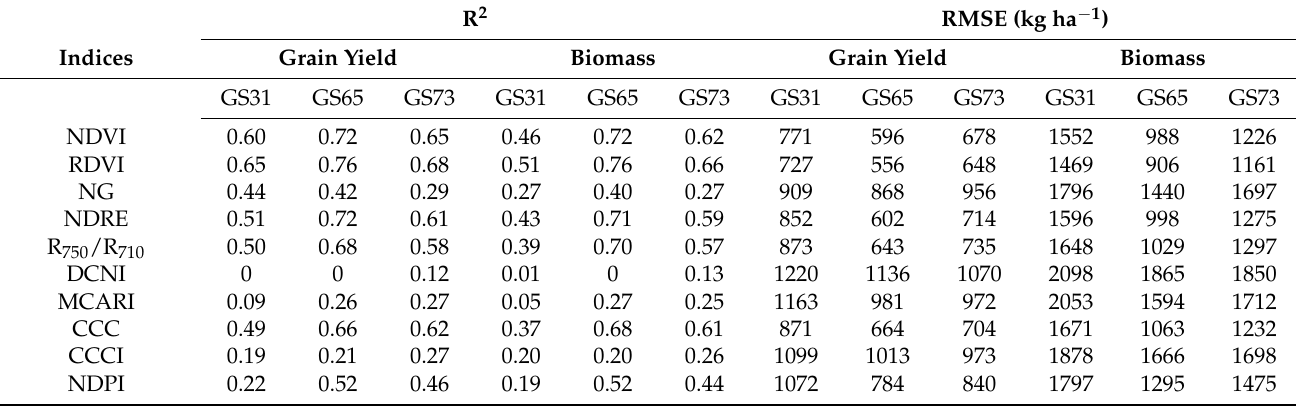
Table 2. Coefficient of determination (R 2 ) and root mean square error (RMSE) between vegetation indices and grain yield and biomass at the beginning of stem elongation (GS31), flowering (GS65), and early milk (GS73). R 2 RMSE (kg ha − 1